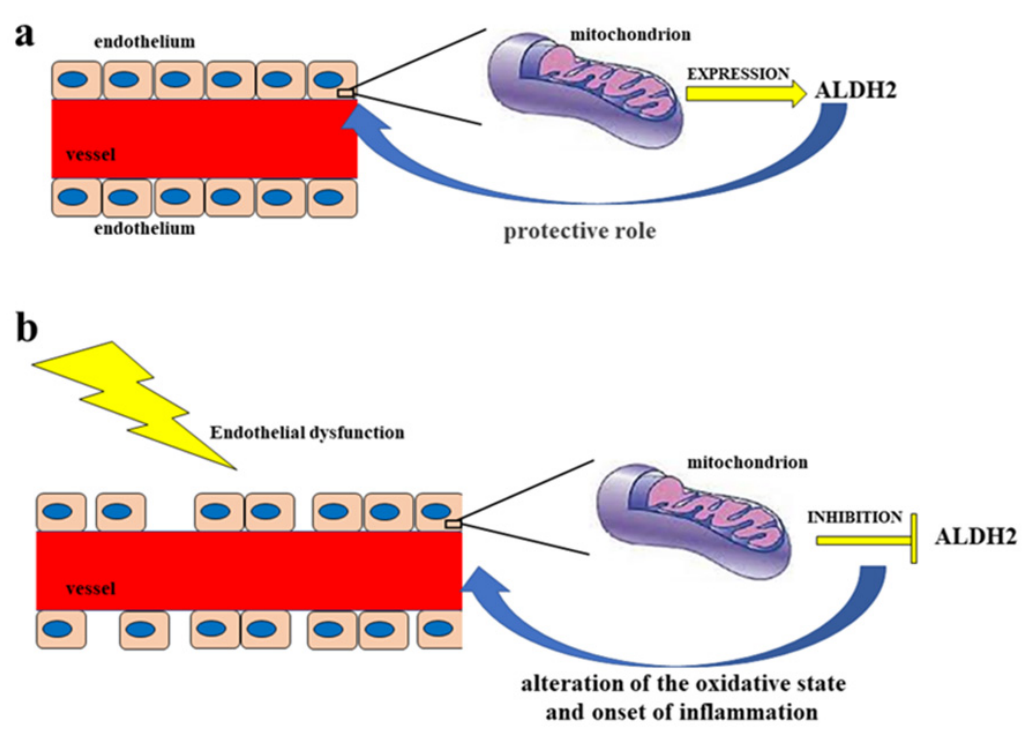
Figure 1. Double control of the endothelium regarding ALDH2. Diagram ( a ) represents a functioning endothelium with a proper mitochondrial expression of the enzyme ALDH2, which has a protective action on the endothelium itself. On the other hand, in diagram ( b ) the dysfunctional endothelium determines the inhibition of the mitochondrial synthesis of ALDH2, with a consequent negative effect on the endothelium, which is undergoing an alteration of the oxidative state and the onset of inflammation.